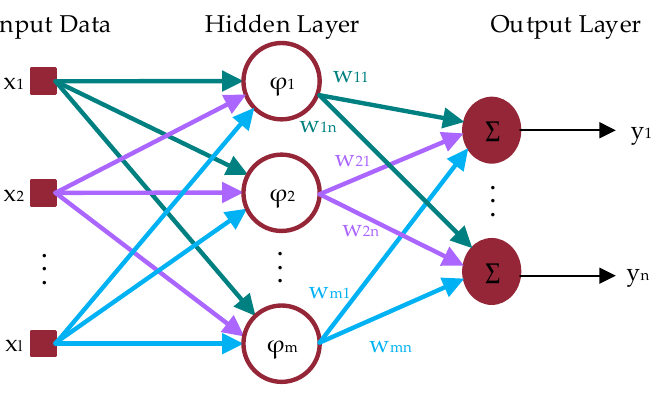
Figure 6. RBF network diagram.